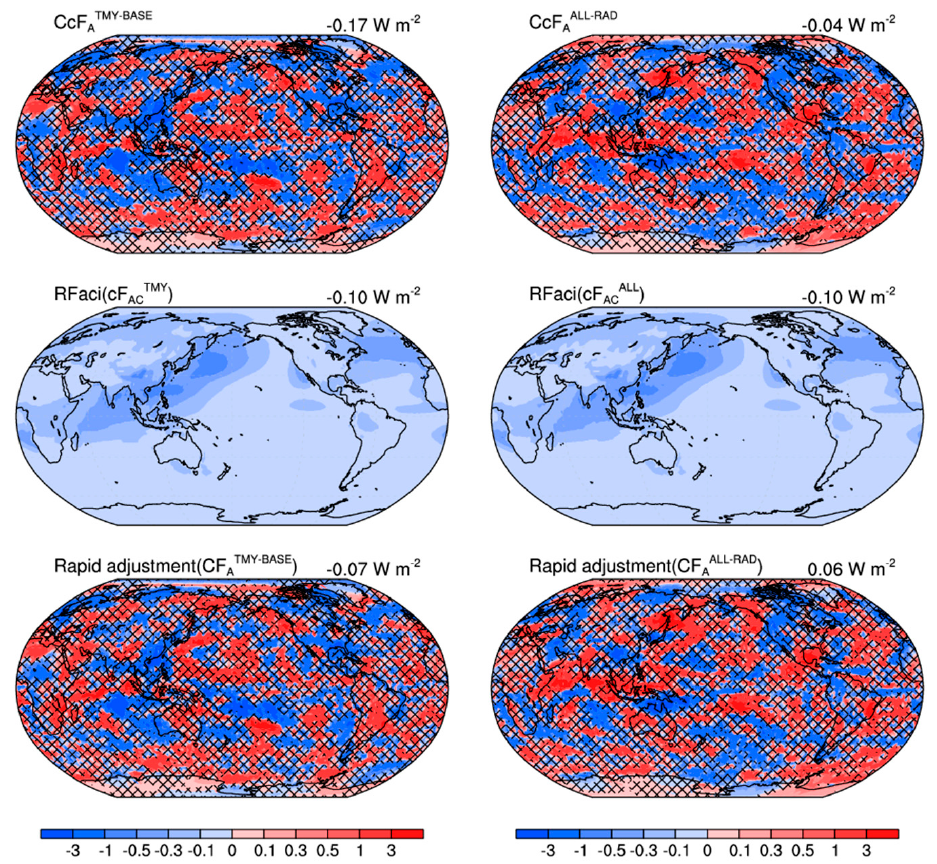
Figure 4. Annual mean anthropogenic aerosol (year 2000) Twomey effect (change in cloud forcing, upper panels ) and its two components: the instantaneous Twomey effect (RFaci, middle panels ) and corresponding rapid adjustment ( lower panels ). The results determined from the TMY and BASE experiments are presented in the left-hand column. The results determined from the RAD and ALL experiments are presented in the right-hand column. The global average is given in the upper-right corner. Hatching represents the nonsignificant area at the 90% confidence level of Student’s t -test.